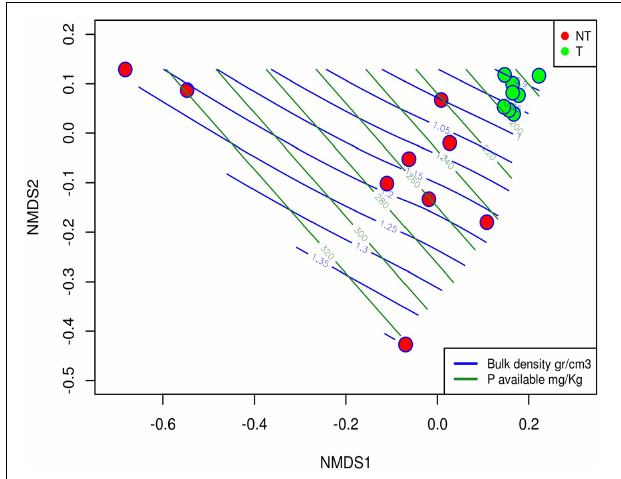
FIGURE 4 | The NMDS plot overlaid with the bulk density and the phosphorus variables represented as isolines and showing the distribution of this variable over the